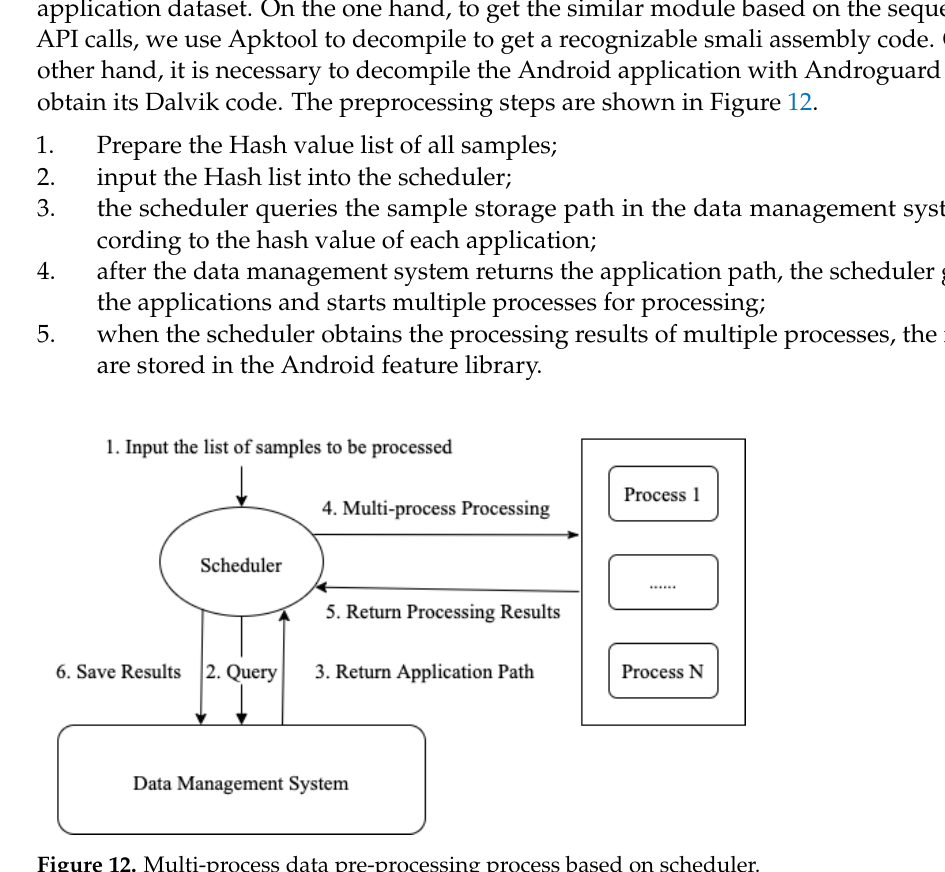
Figure 12. Multi-process data pre-processing process based on scheduler.